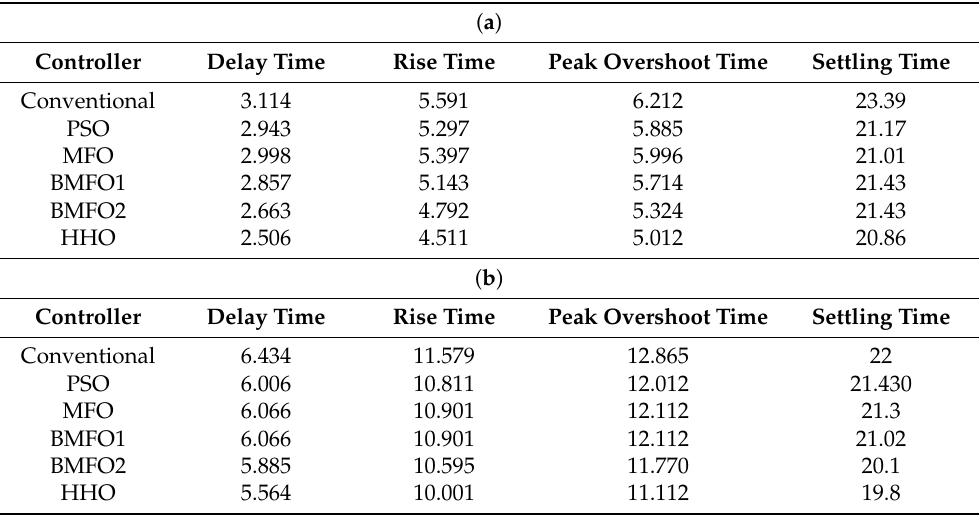
Table 14. ( a ). Graph analysis of GENCOs to DISCOs generation response of Area2 with various controllers under bilateral contract. ( b ). Graph analysis of DISCOs to GENCOs generation response of Area2 with various controllers under bilateral contract.